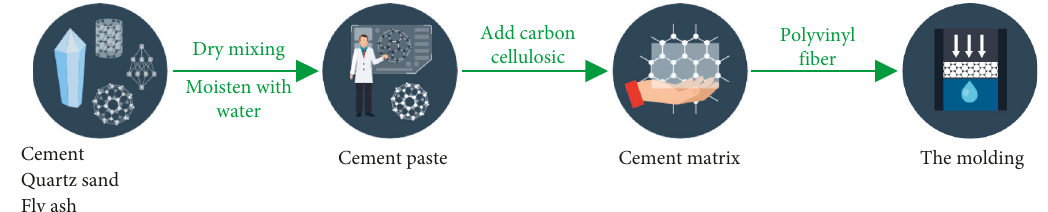
Figure 1: Cement-based composite